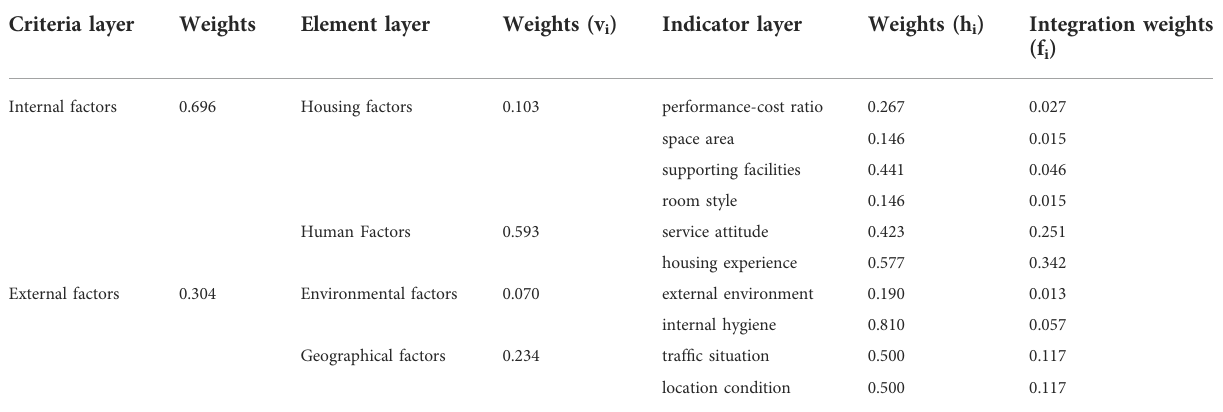
TABLE 10 Table of index